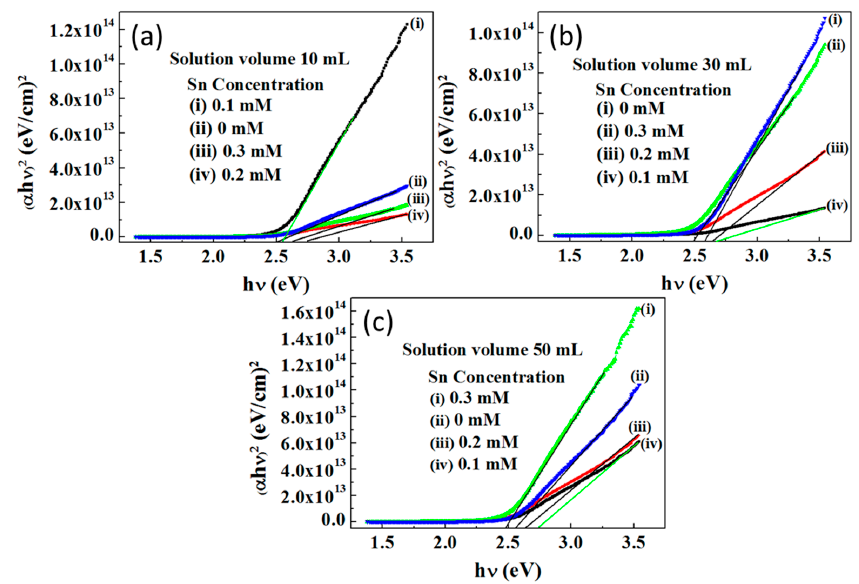
Figure 7. ( α h ν ) 2 vs (h ν ) plots of the films with different volumes and Sn-doping concentrations. Table 3. Optical band gap of doped and un-doped CdO thin films.